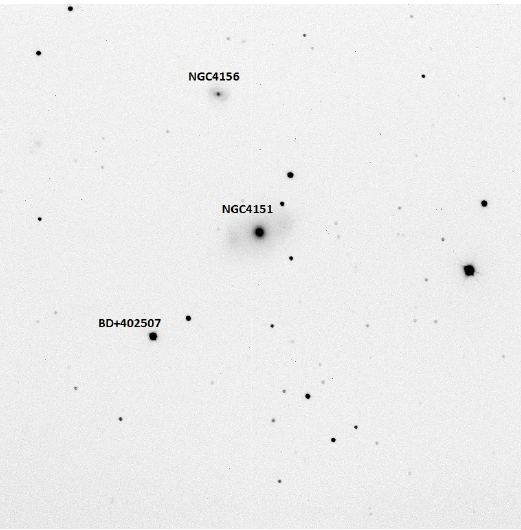
Fig. 2. Image of the Seyfert galaxy NGC 4151 taken with the 1-meter telescope of Tien-Shan Astronomical